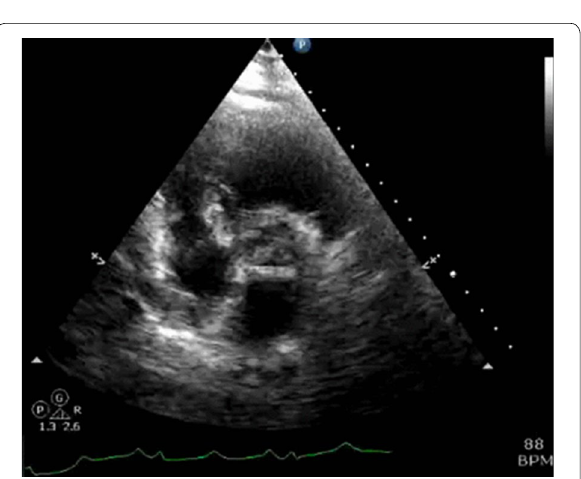
Fig. 4 Parasternal short axis view of large mobile thrombus in the right